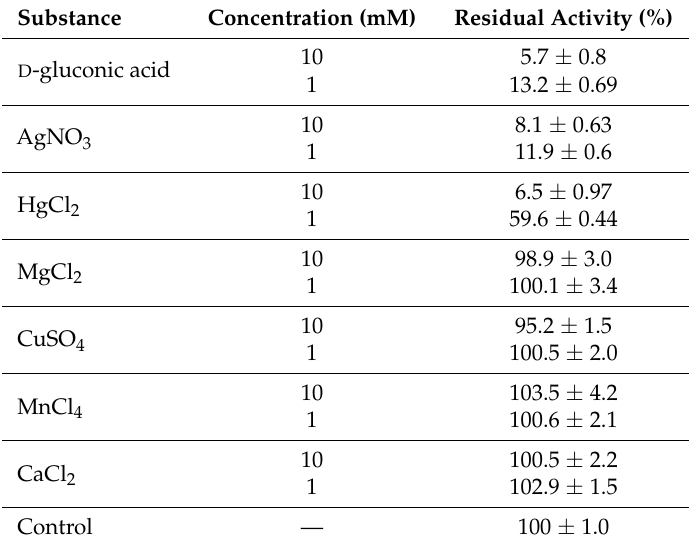
Table 4. Effect of different substances on the activity of BcXyl.